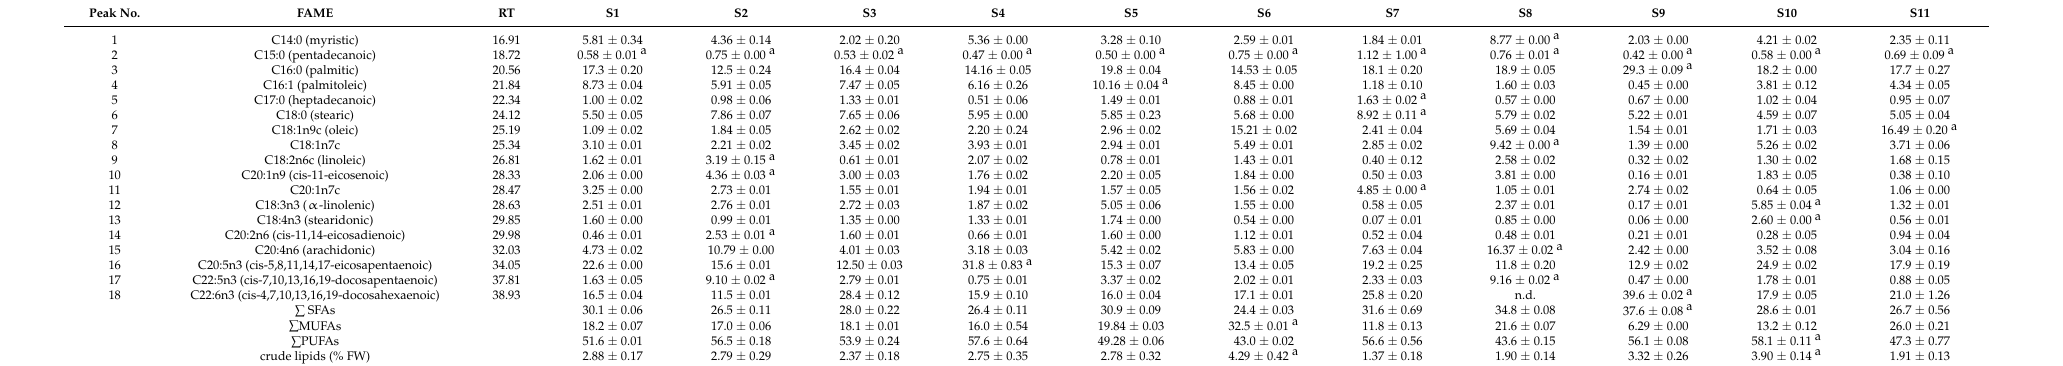
Values (mean ± standard deviation) are percentages of the total fatty acids from three determinations. FAME: fatty acid methyl ester; n.d.; not detected; RT: retention time; FW: fresh weight; PUFAs: total polyunsaturated fatty acids; MUFAs: total monounsaturated fatty acids; SFAs: total saturated fatty acids; a The mean value is significantly ( p < 0. 05) highest among the studied species. The sample numbers (S1 to S11) are correspondent to Table